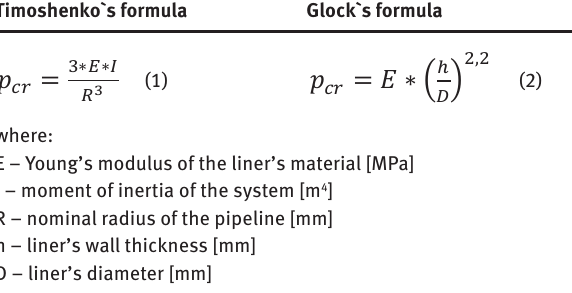
Table 1: Critical pressures according to the Timoshenko`s and Glock`s